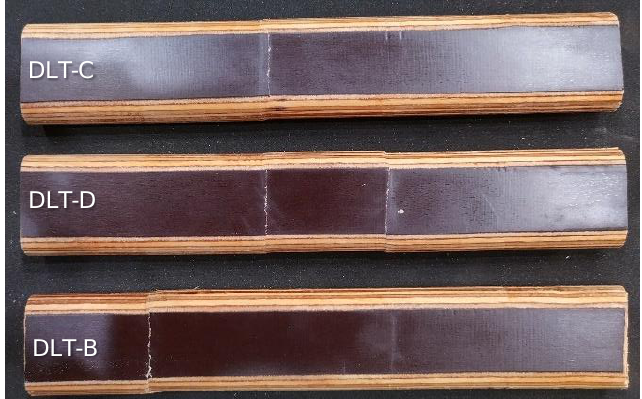
Figure 9. Shear deformations in the salvaged plywood tenons.